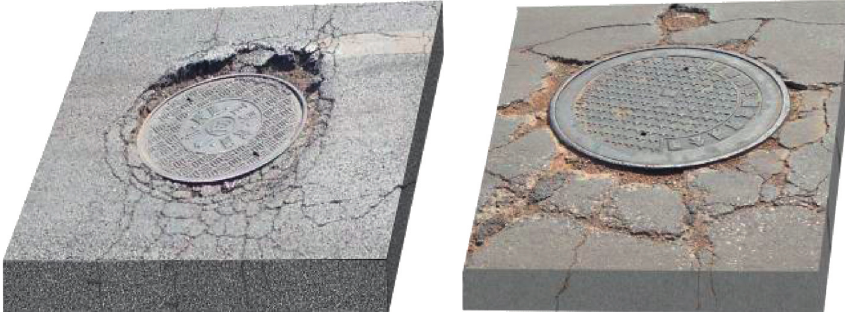
Figure 1: Damage to manholes and paving around